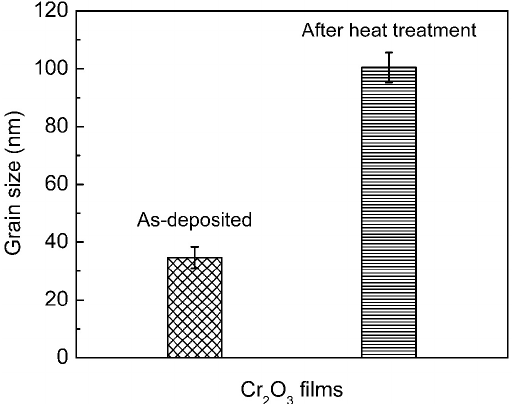
Figure 7. Average grain size of the as ‐ deposited and heat ‐ treated Cr 2 O 3 films.